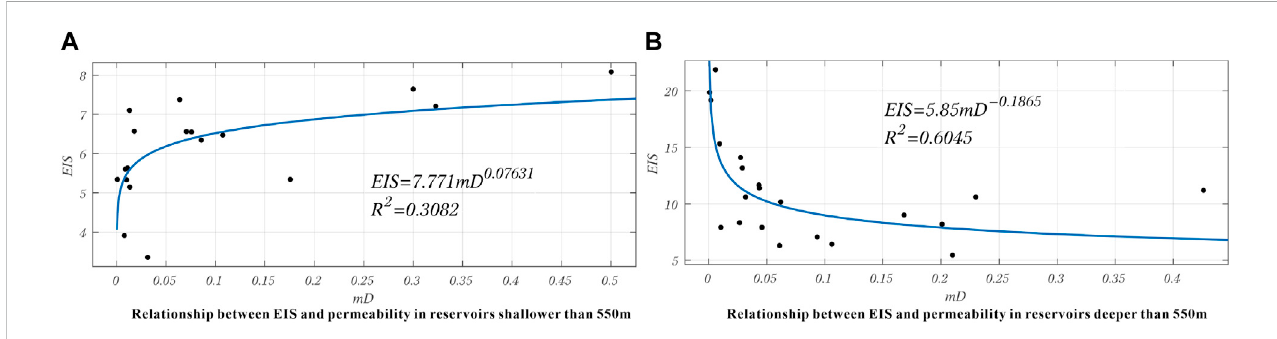
FIGURE 12 Power function fi tting results of effective stress and